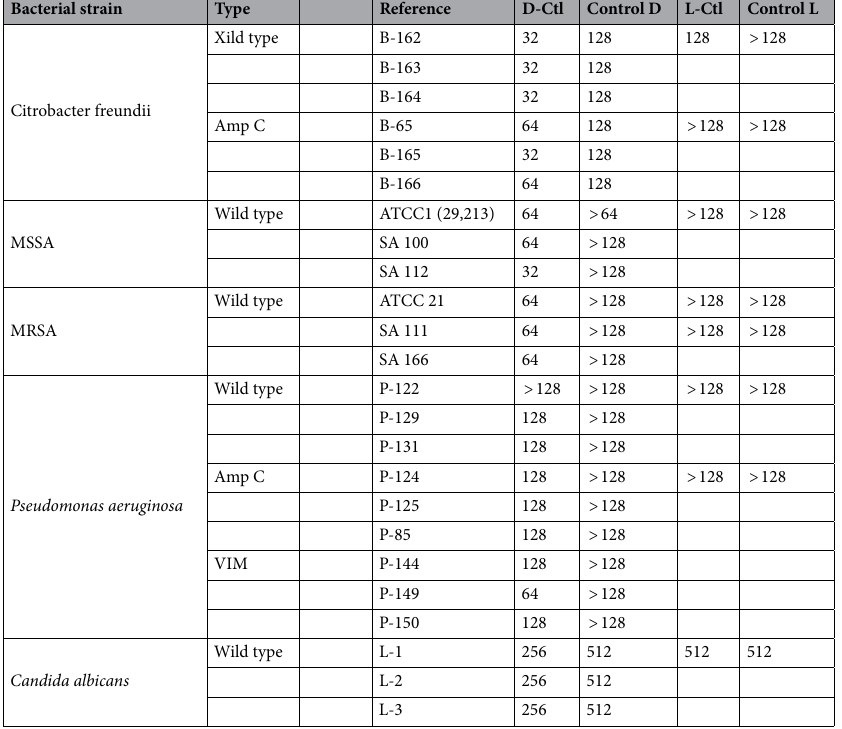
Table 2. Antimicrobial activities of L- and D- Ctl and the corresponding scrambled peptides (controls) against resistant pathogens (MIC,